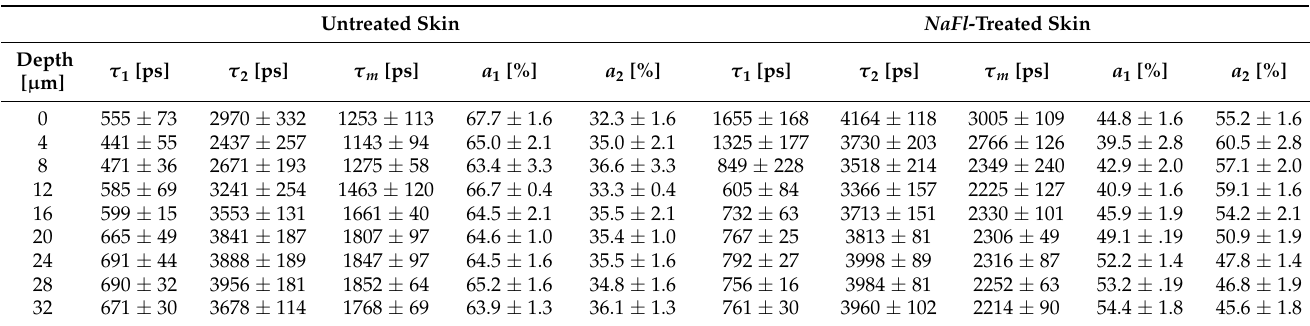
Table 3. TPE-FLIM parameters of untreated and NaFl -treated skin. Mean ± SEM. N = 6. Untreated Skin NaFl -Treated Skin